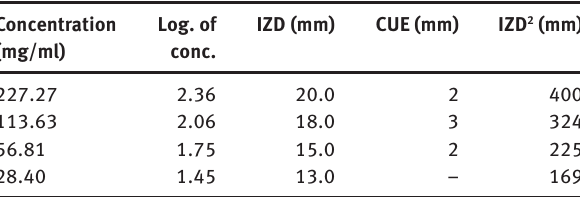
Table 1: Effects of varying concentrations and log concentration on IZD, CUE, and IZD 2 of silverneem on Fusarium moniliforme. Concentration (mg/ml)